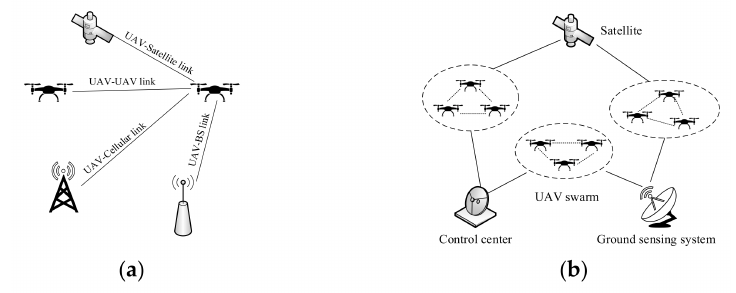
Figure 5. ( a ) Four link modes; ( b ) structure diagram of